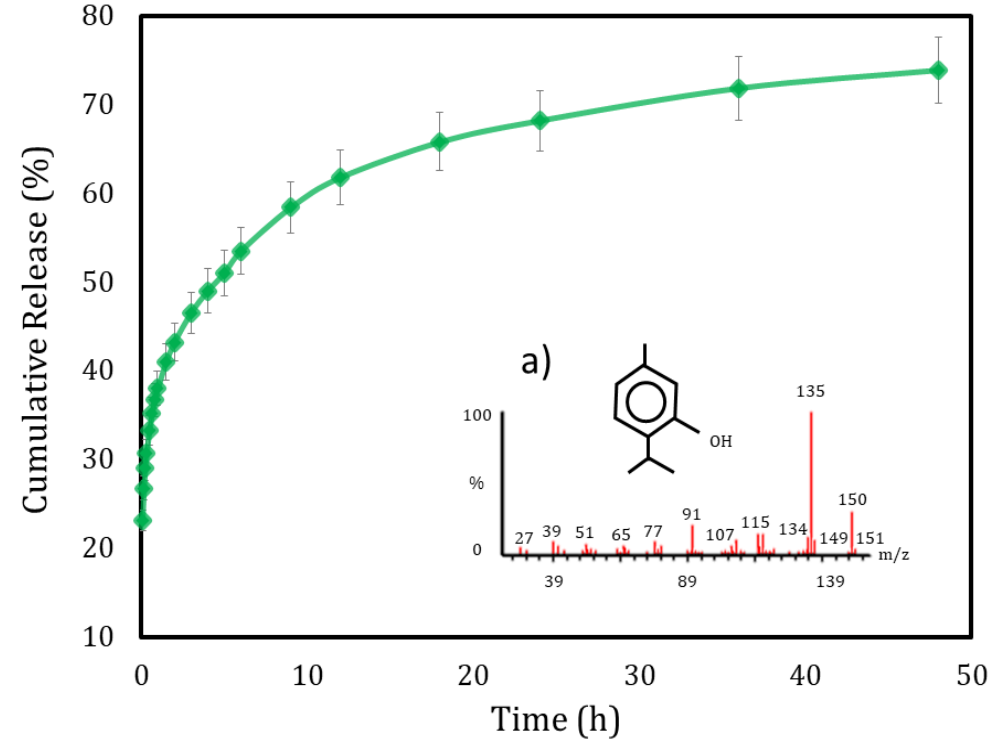
Figure 1. In vitro release profile obtained for the chitosan-thyme nanocapsules, (a) mass spectrum of thymol found in thyme essential oil (majority compound in the sample).